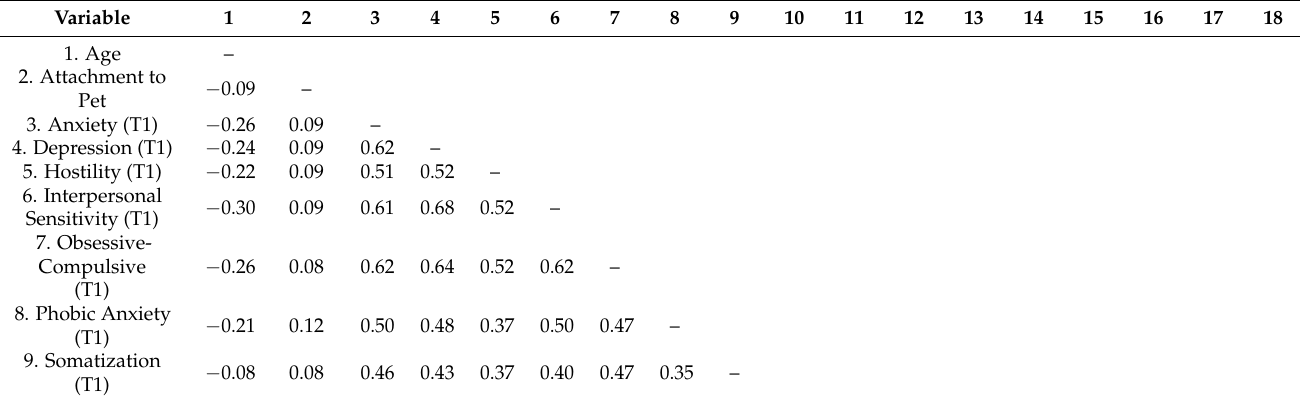
Table 2. Intercorrelations, Unstandardized Means, and Standard Deviations of Continuous Key Variables.